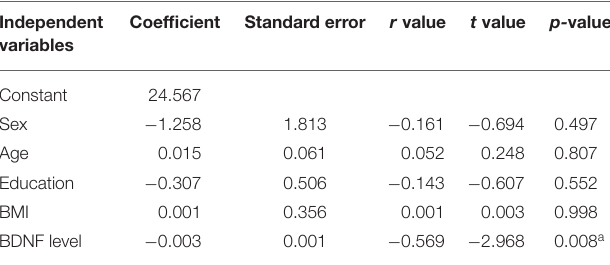
TABLE 4 | Multivariate regression models for RLS severity assessed by IRLSSG-RS scores in controls with RLS. Independent